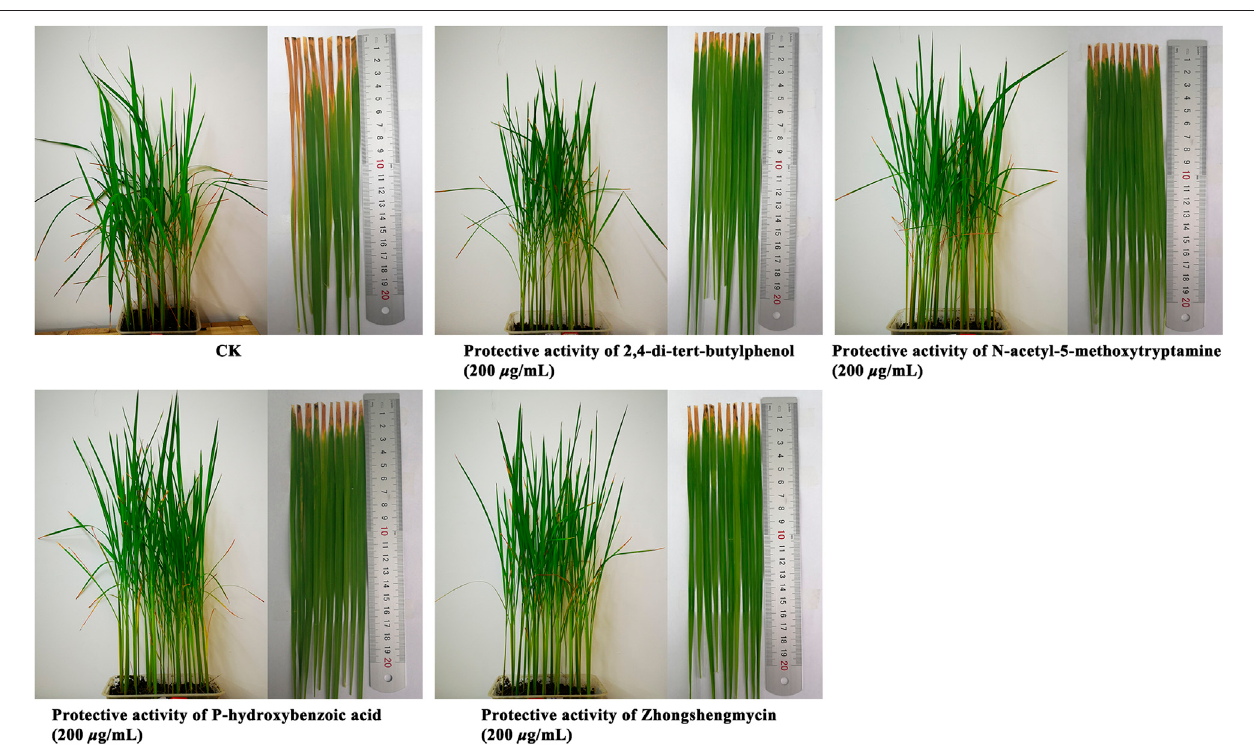
FIGURE 4 | Protective activity of 2,4-di-tert-butylphenol, N-acetyl-5-methoxytryptamine, P-hydroxybenzoic acid against BLB at concentrations of 200 μ g/ml.